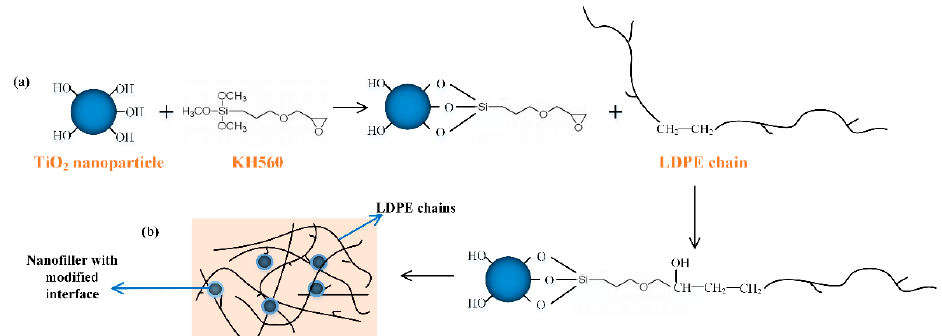
Figure 1. Schematic of surface modification and nanocomposite. ( a ) Surface modification of TiO 2 nanoparticle; ( b ) schematic figure of low-density polyethylene (LDPE)/TiO 2 nanocomposites matrix.